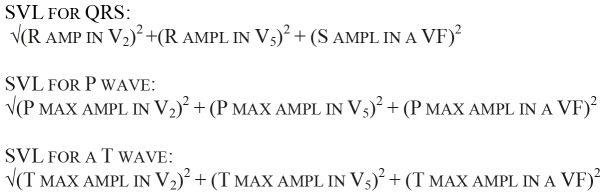
Spatial vector length (SVL) formulas for P-wave, T-wave, and QRS amplitudes.These computations work to solve for the Spatial Vector Length, which represents the maximum electrical energy emitted by the heart.